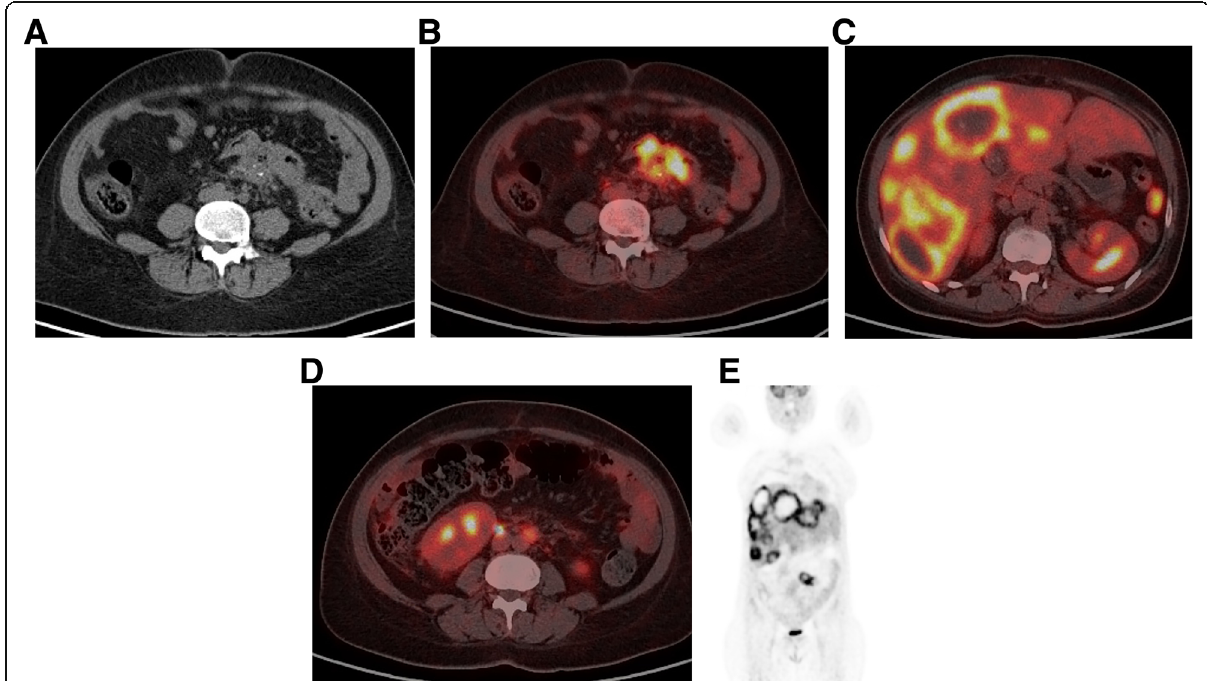
Fig. 2 A 45-year-old male patient presented with pathologically proven metastatic adenocarcinoma hepatic focal lesions. PET/CT revealed axial CT ( a ) and fused PET/CT ( b ) images showing FDG avid metabolically active sigmoid colon irregular mural tumefaction (SUVmax 15.2 suggested site of primary malignancy) with few pericolic metabolically active lymph nodes. Axial fused PET/CT images showing ( c , d ) multiple hepatic, peritoneal, and para-aortic nodal metastatic deposits. Coronal PET image ( e ) shows sigmoid colon tumor and hepatic deposits. Endoscopic biopsy